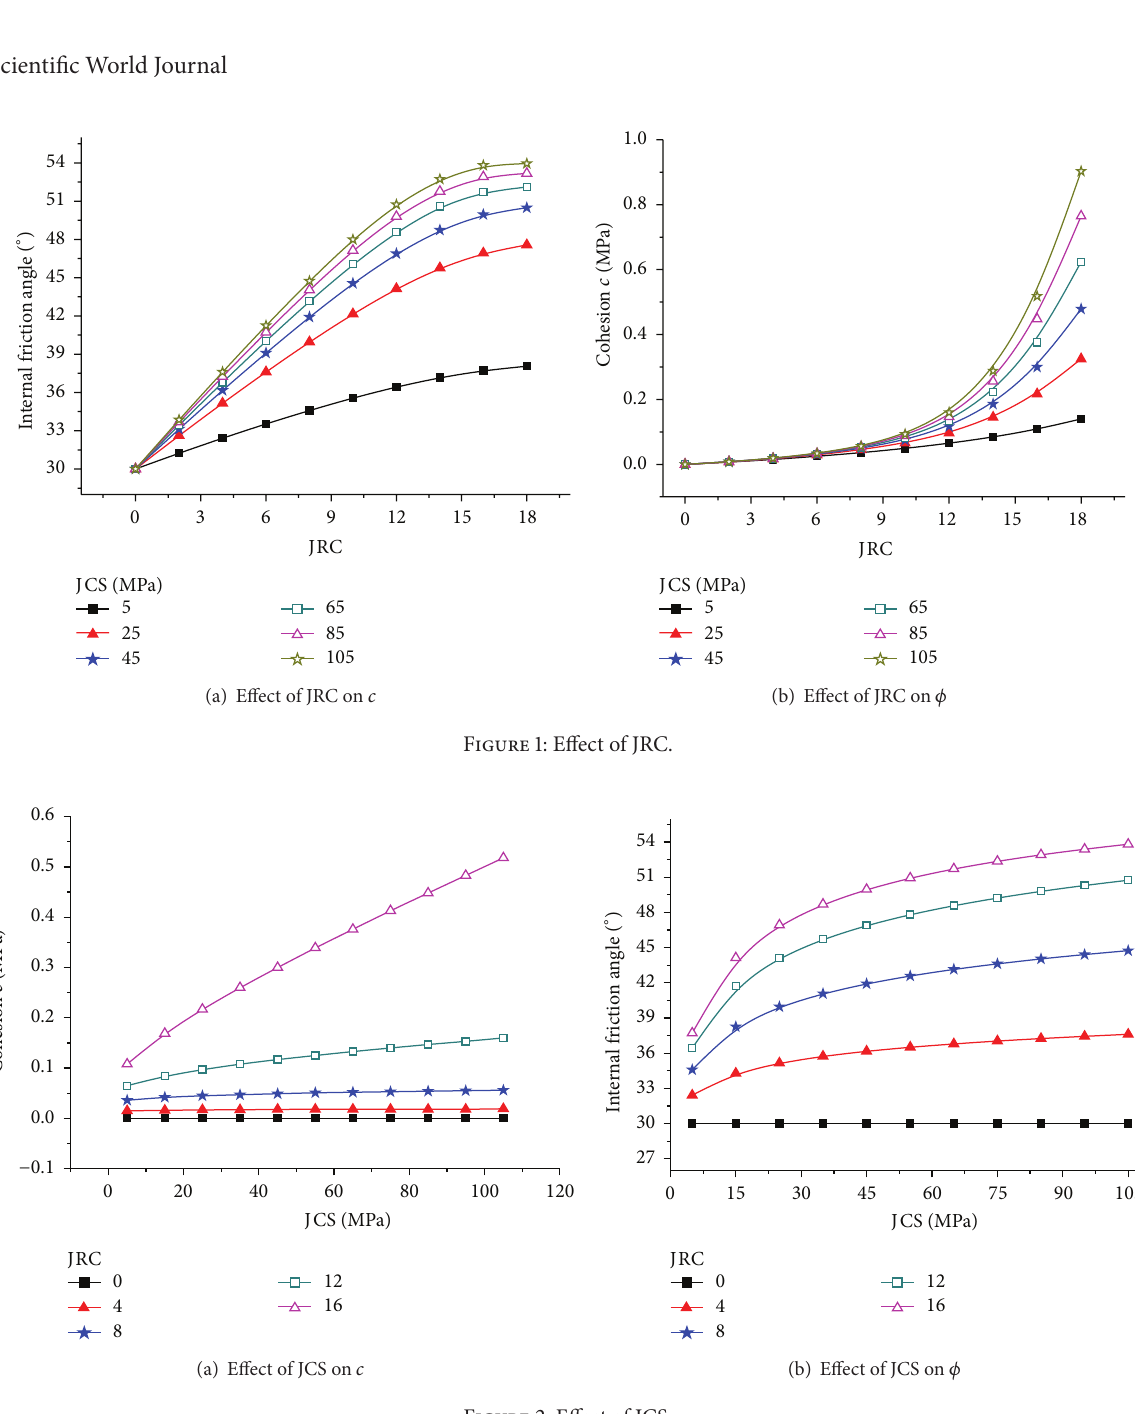
Figure 2: Effect of